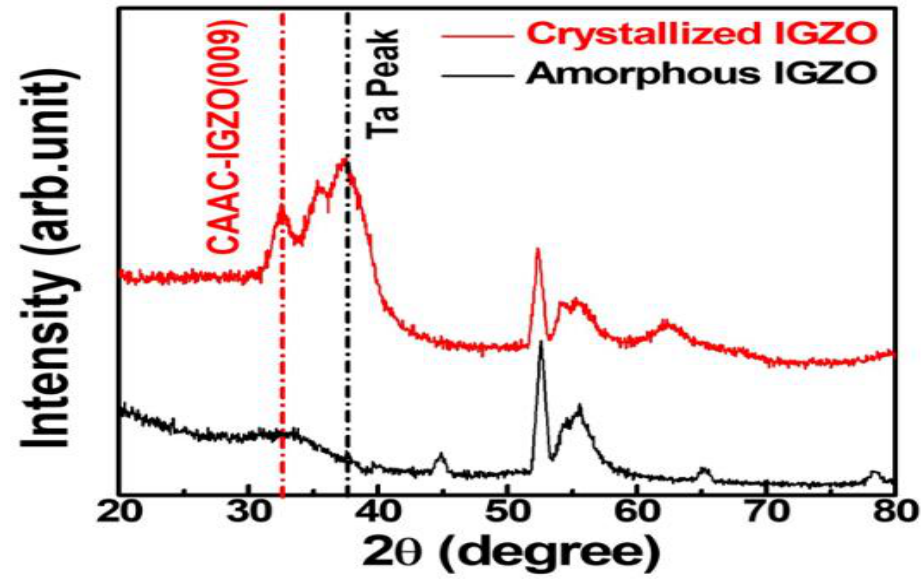
Figure 1. XRD spectra of the IGZO thin film without and with Ta metal film that was annealed at 300 °C under O 2 ambient for 1 h.